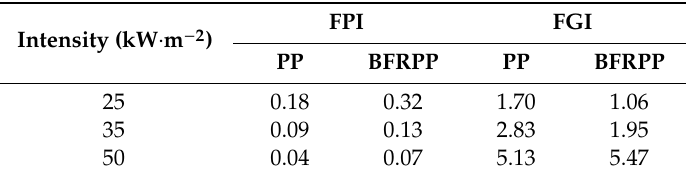
Table 7. The fire propagation index (FPI) and the fire growth index (FGI) of PP and BFRPP samples under di ff erent heat fluxes.